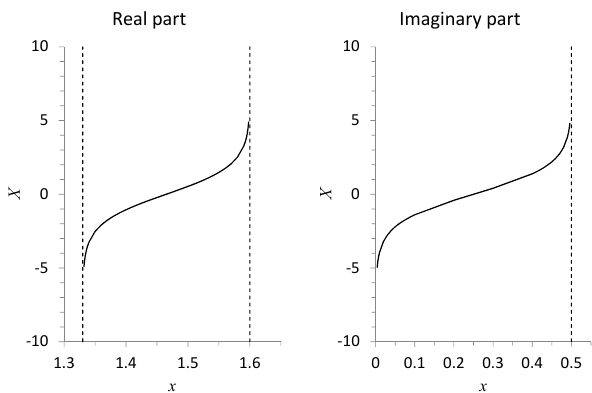
Figure 3. Transformation of the real and imaginary parts of the re- fractive indices by Eq. (20). Minimum and maximum values of the real part are 1.33 and 1.6 and those of the imaginary part are 0.0005 and